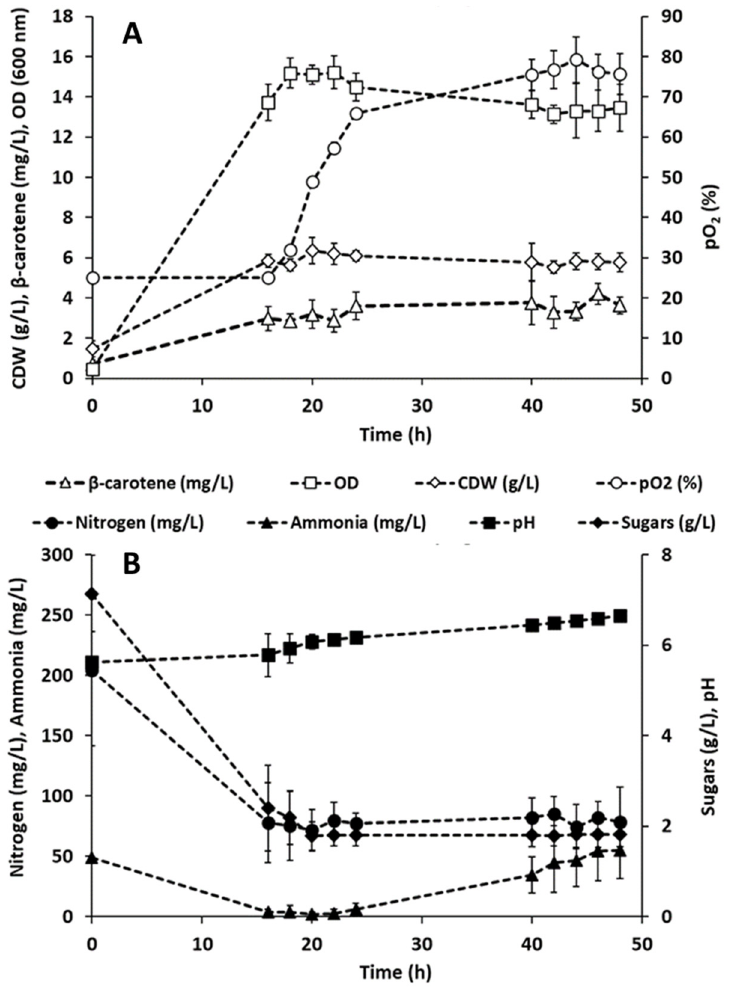
Figure 5. R. toruloides fermentation in stirred tank bioreactor (batch mode) with 9% ( w / v ) Camelina meal hydrolysed with 0.56% w / w Camelina meal of NS22119 as growth medium. Profile over time of β - carotene production (empty triangles), optical density (empty squares), cellular dry weight (empty diamonds), pO 2 (empty circles)—panel A ; nitrogen titer (full circles), ammonia titer (full triangles), sugars titer (full diamonds) and pH (full squares)—panel B . Values are the means of three inde- pendent experiments.